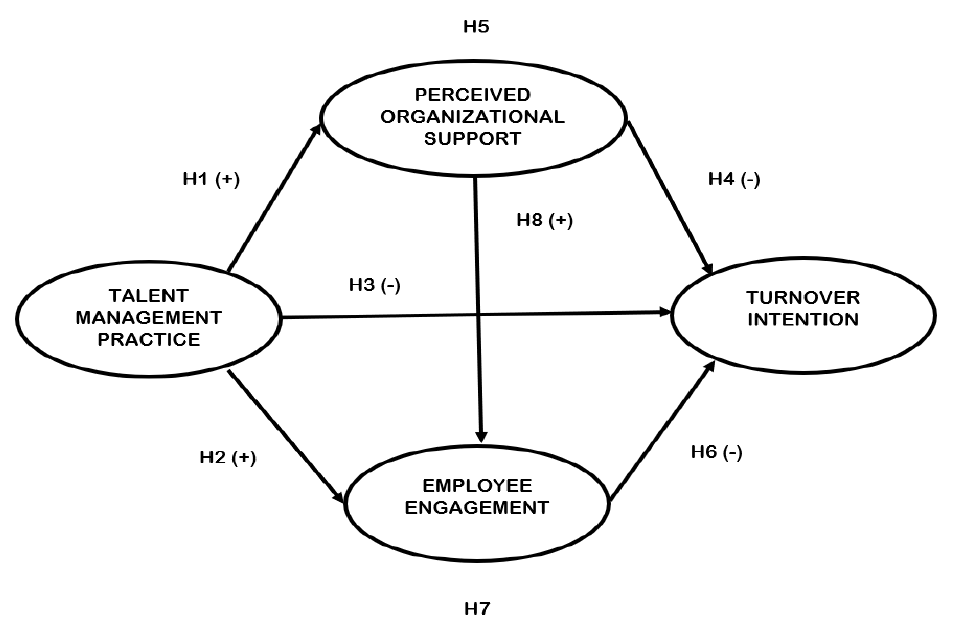
Figure 1. Integrated Conceptual